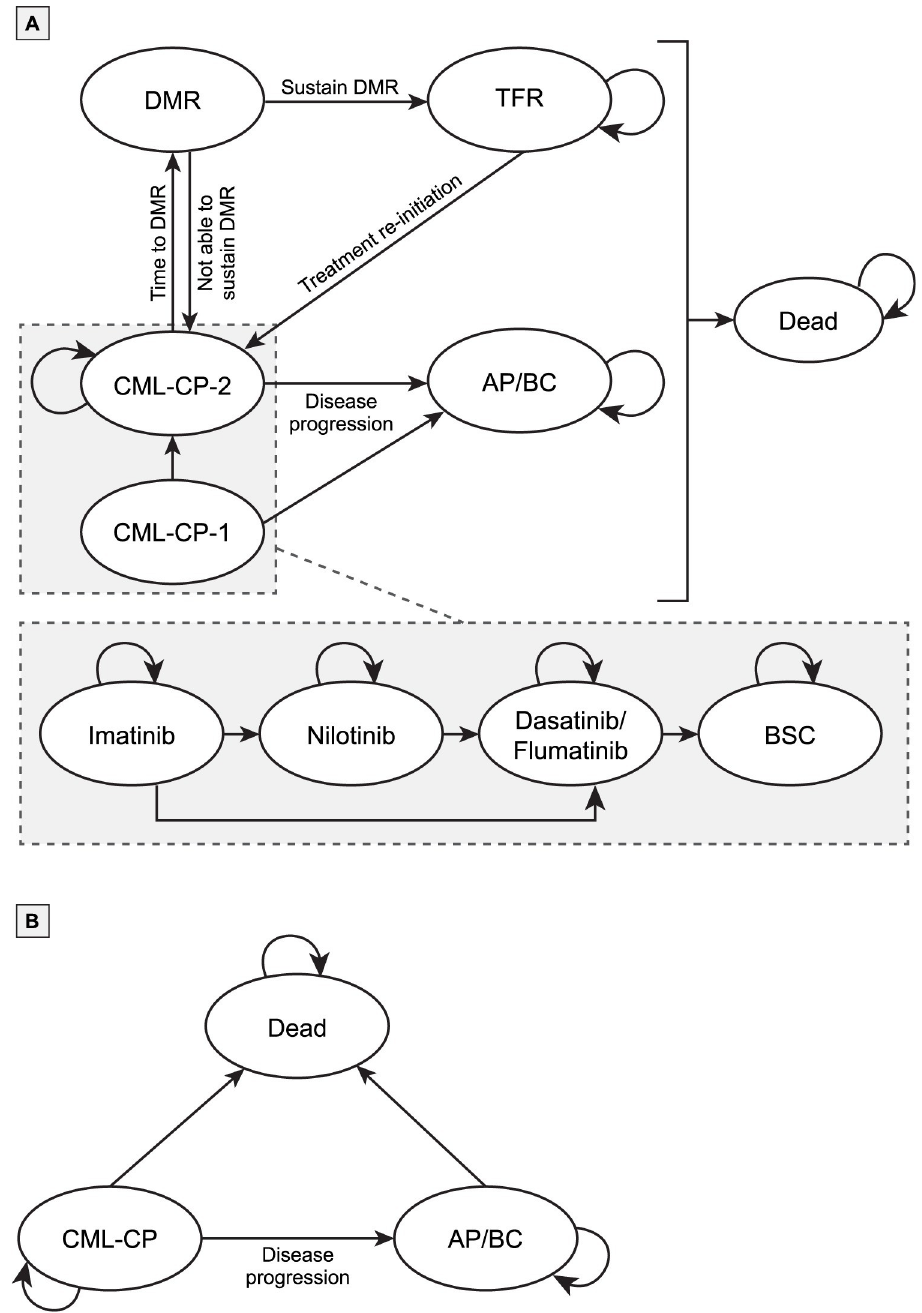
Fig 1. Structure of the Markov model. Abbreviations: AP, Accelerated Phase; BC, Blast Crisis; CML-CP, Chronic Myeloid Leukemia; DMR, Deep Molecular Response; TFR, Treatment Free Remission. Without regular monitoring, physicians cannot identify if the patient has achieved DMR and hence are not eligible for treatment discontinuation/TFR [37]. As such, CML-CP patients who did not receive molecular monitoring remained in the CML-CP health state, transitioned to the AP/BC health state, or transitioned to death (Fig 1B).